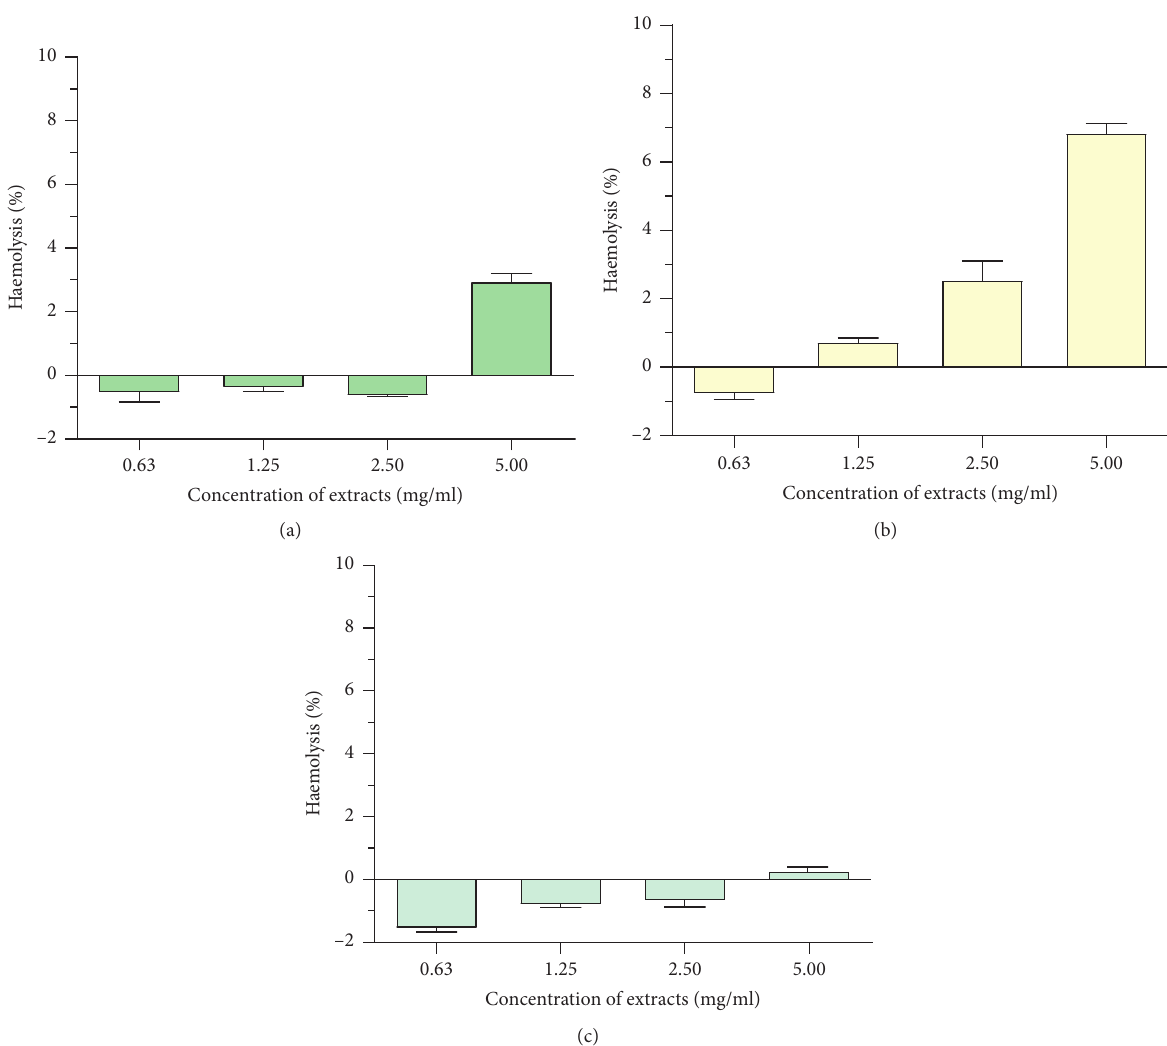
Figure 3: The effect of extracts of P. curatellifolia on haemolysis of sheep erythrocytes. (a) DCM: methanol extract, (b) water extract, and (c) hexane extract. The erythrocyte suspension was incubated with an equal volume of test sample extracts; A, B, and C dissolved in PBS, at varying concentrations from 0.625 to 5 mg/ml at 37 °